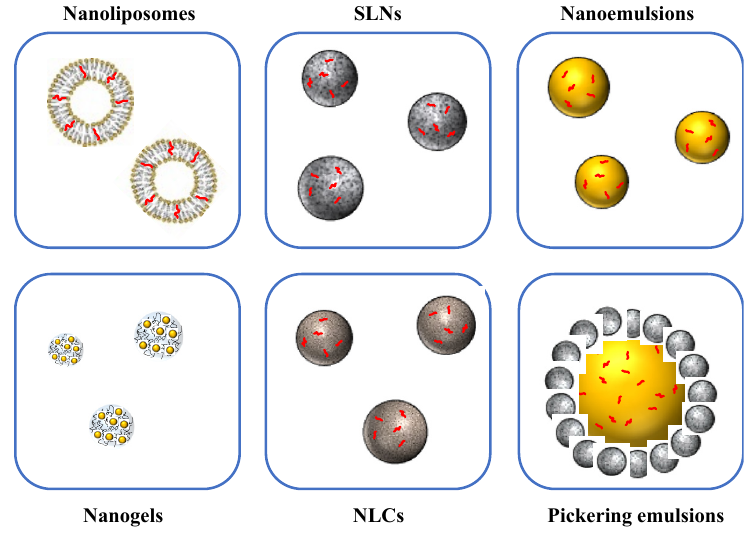
Figure 2. Various kinds of edible nanoparticles are available to encapsulate, protect, and delivery bioactive substances in foods.